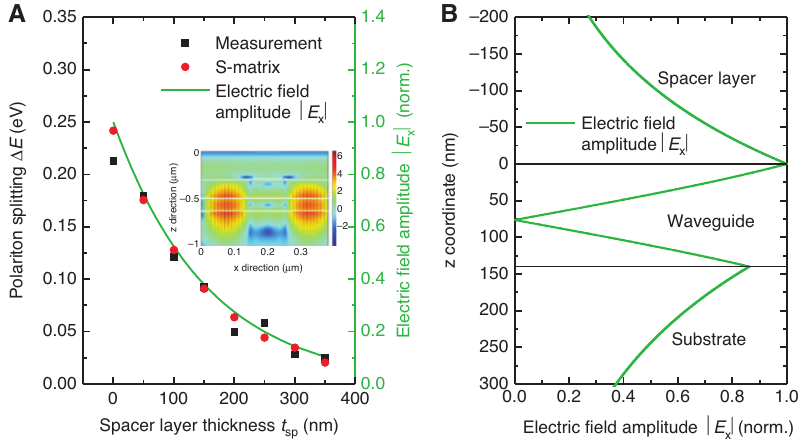
Figure 4: Correlation between polariton splitting and electric field amplitude. (A) Polariton splitting Δ E as a function of spacer layer thickness t for experimental data (black squares) and simulated data (red circles) sp compared to the normalized electric field amplitude | E | (green line) at the vertical position of the metal grating as a function of spacer layer x ≈ 1.571 × 10 7 m −1 . Inset: field plot for E thickness for a propagation constant β (transverse cross-section) at E = 1.935 eV. (B) Exemplary | E p x field plot of an undisturbed waveguide mode as a function of the vertical coordinate z for a spacer layer thickness of 200 nm.